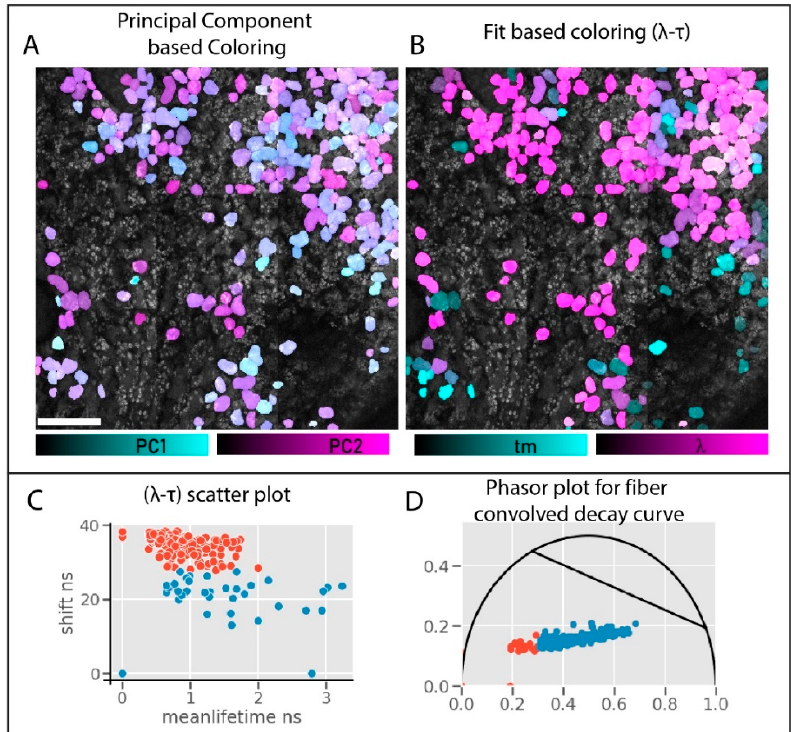
Figure 7. HDIM PCA vs. fiber-HDIM. The PCA analysis result ( A ) is compared against the mean lifetime -spectral shift map (lambda-tau) map ( B ). The PC1-PC2 colors separate the plant cells poorly; however, lambda-tau maps show separation and further distinguish anthocyanin distribution better (panel B ). The 2D scatter plot of the cells in panel ( B ) is shown in panel ( C ). The two separate clusters are visualized. Panel ( D ) shows a fit-free analysis of the spectrally coded lifetime data, which resolves two species. These cells (blue-scatter plot in phasor) are prominent in magenta color in panel ( B ), show a relatively lower lifetime, and represent a higher anthocyanin accumulation. The black line on the phasor plot is shown as a reference for 0.5 ns and 3.0 ns as the regular anthocyanin lifetime limits.